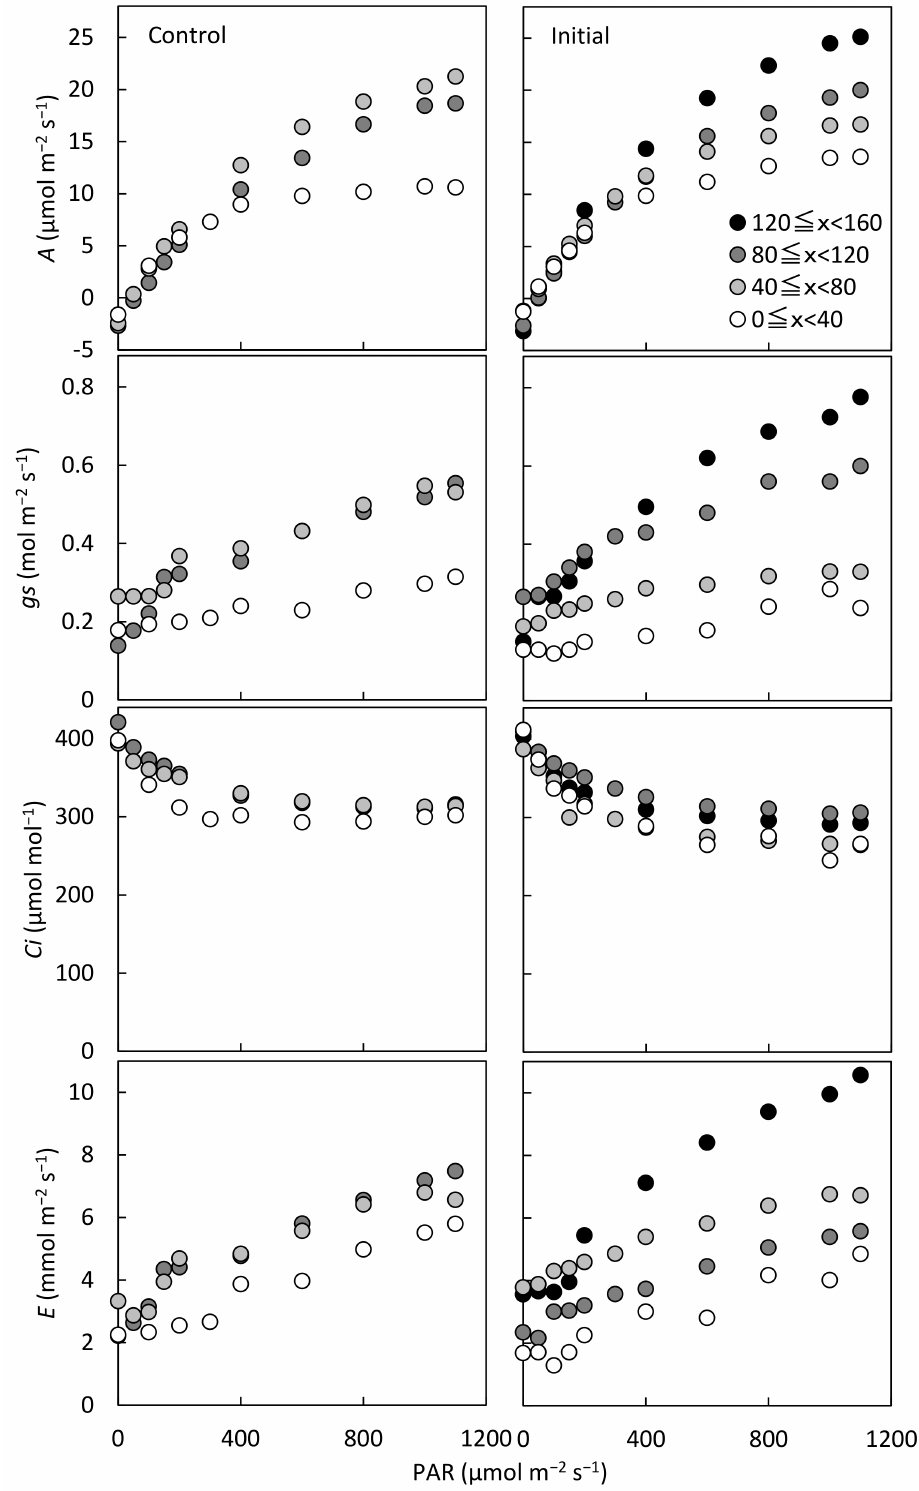
Figure 2. Responses of photosynthetic rate ( A ), stomatal conductance ( gs ), intercellular CO 2 concen- tration ( Ci ), and transpiration rate ( E ) to photosynthetic active radiation (PAR) at different levels of the crop